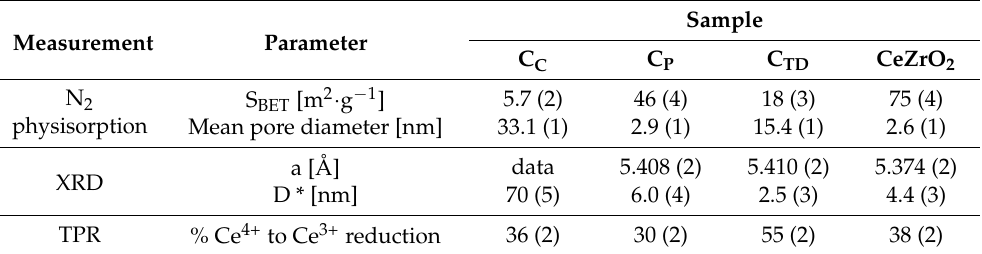
Table 1. Results of characterization measurements: lattice parameter of the support (a), average support particle size (D), specific surface area (S BET ), mean pore size and degree of reduction of ceria in the supports. The absolute error of the determination is written in brackets after the number. Measurement